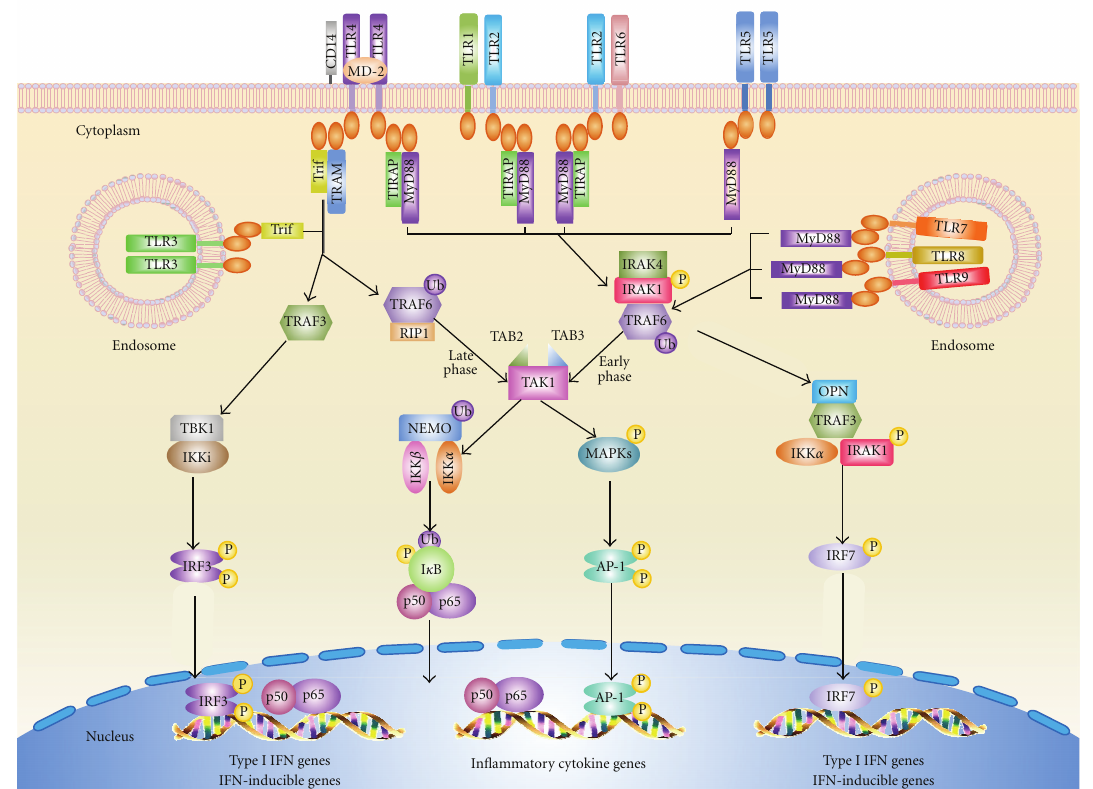
Figure 1: TLR signaling pathways. Upon respective ligands binding, TLRs form homo- or heterodimers and recruit one or more adaptor proteins, namely, MyD88, MAL/TIRAP, TRIF, or TRAM, to the cytoplasmic domains of the receptors through homophilic interactions between Toll/IL-1 receptor (TIR) domains present in each receptor and each adaptor. All TLRs with exception of TLR3 use the common MyD88-dependent pathway. TIRAP acts as a bridge to recruit MyD88 to TLR2 and TLR4 signaling, whereas TRIF is used in TLR3 signaling and, in association with TRAM, in TLR4 signaling. In MyD88-dependent pathway, MyD88 associates with IRAK4, IRAK1, and/or IRAK2. IRAK4 in turn phosphorylates IRAK1 and/or IRAK2 and promotes their association with TRAF6, which serves as a platform to recruit and activate the kinase TAK1. Activated TAK1 activates the IKK complex, composed of IKK α , IKK β , and NEMO (IKK γ ), which in turn catalyzes phosphorylation and subsequent degradation of I κ B. I κ B degradation lets NF- κ B ( i.e., p50/p65) free to translocate from the cytoplasma to the nucleus, where it activates multiple gene expression. The transcription factor IRF7 is activated as the downstream signaling molecule of TLR 7, 8, and 9. It is directly phosphorylated by IRAK1 and then translocates into the nucleus to induce the expression of type I IFN and IFN-inducible genes. In the Trif-dependent pathway, Trif interacts with TRAF3 to activate TBK1 and IKKi, resulting in the dimerization and activation of IRF3, which then translocates into the nucleus activating the transcription of type I IFN and IFN-inducible